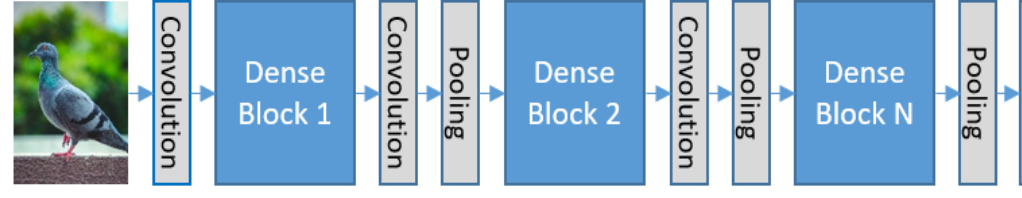
Figure. 1 The framework of